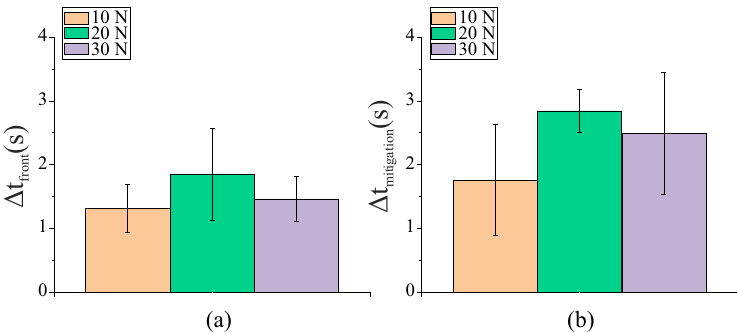
Figure 10. Graphs showing the mean time difference (N = 10) between the ( a ) detection of slip at the outer and middle grasper islands ( ∆ t front ) and ( b ) available mitigation time ( ∆ t mitigation ) for a variation in the clamp force with a 2 mm/s retraction speed. The error bars indicate the standard